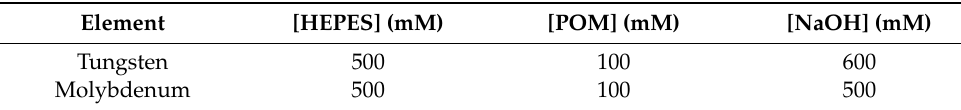
Table 1. Final concentrations of the POM stock solutions. Element [HEPES] (mM) [POM] (mM) [NaOH] (mM) Tungsten 500 100 600 Molybdenum 500 100